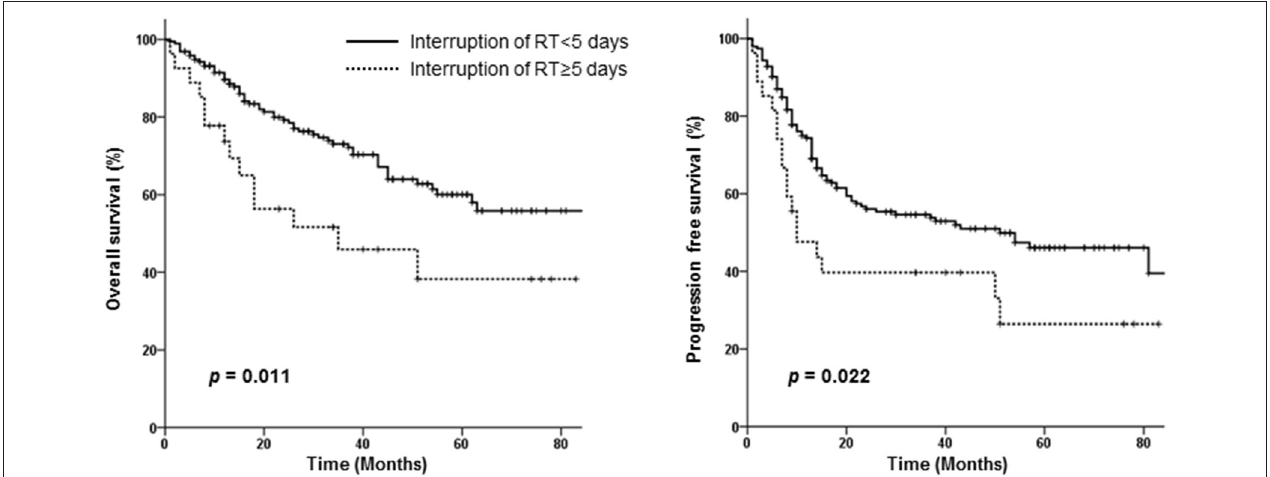
FIGURE 3 | Overall and progression-free survival curves of patients requiring interruption of radiotherapy for < 5 days vs. those requiring interruption for ≥ 5